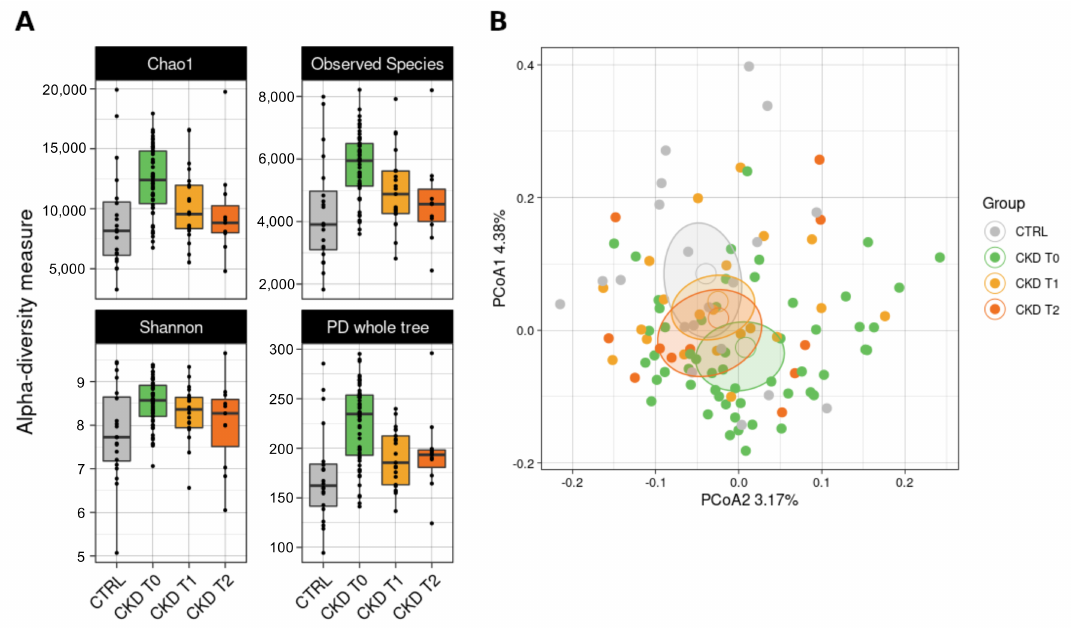
Figure 5. Biodiversity and phylogenetic analysis between cohorts. Bacterial ecological diversity was assessed between CTRL group (grey), CKD group at baseline (green), and CKD groups supplemented with curcumin (CKD T1, yellow; CKD T2, orange). ( A ) Alpha-diversity analysis with Chao1, observed species (OTU count), Shannon index, and Faith’s phylogenetic tree metrics. ( B ) Principal coordinates analysis showing the unweighted Unifrac beta-diversity; the first and second principal coordinates (PCoA1 and PCoA2) are